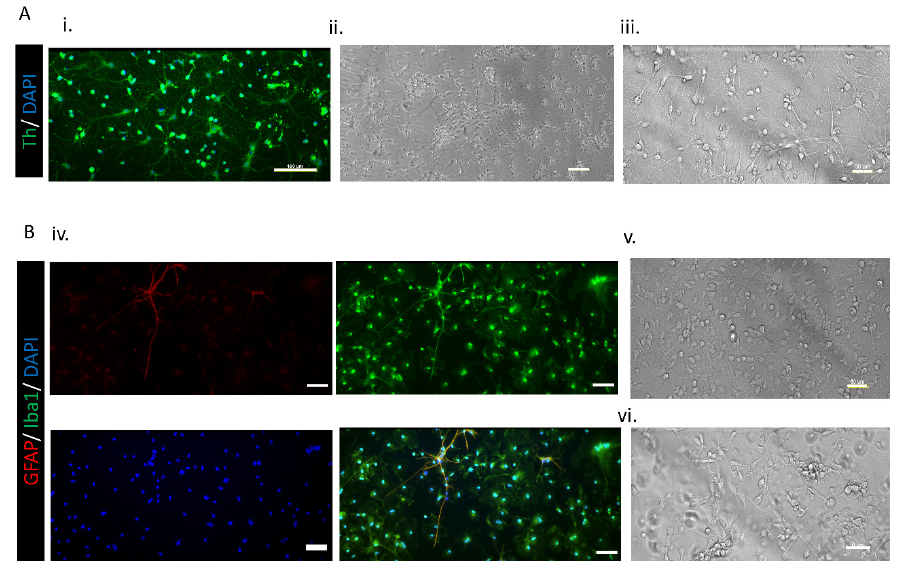
Figure 6. ( A ) Images of the primary dopaminergic cell culture. i: Immunofluorescence staining: positive for TH dopaminergic marker. (Scale bar 100 µM) ii: (scale bar 100 µM) and iii: (scale bar 50 µM) Bright field images of primary dopaminergic cell cultures. ( B ) Images of the primary microglia cell culture. Iv: Immunofluorescence staining. (Scale bar 50 µM) v: Bright field images of glia mix culture. (Scale bar 50 µM). vi: Bright field images of the primary microglia cell culture after isolation. (Scale bar 50 µM).